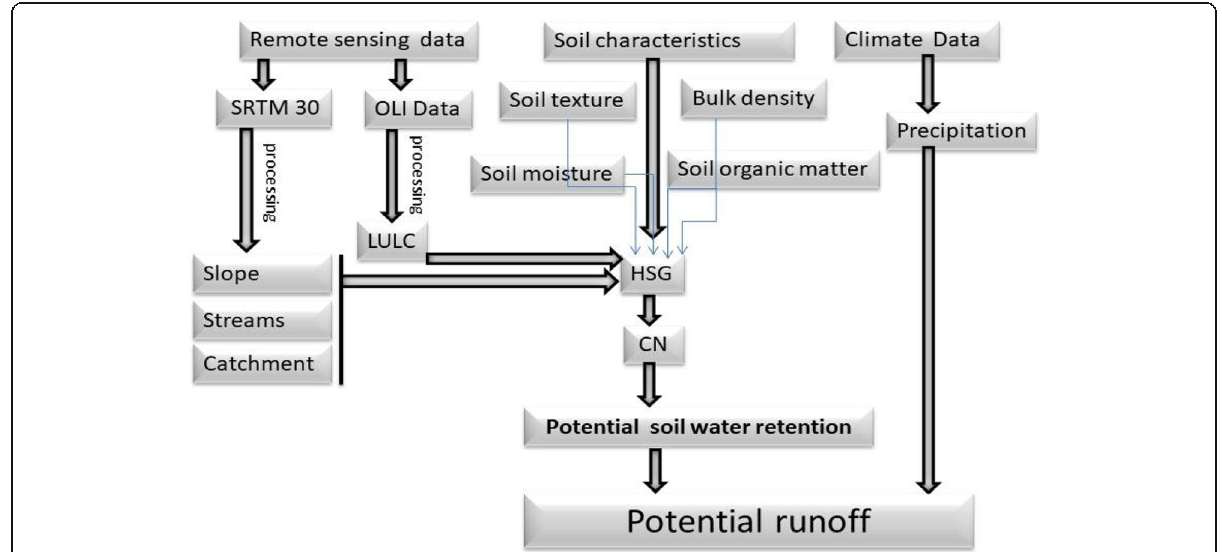
Fig. 2 Flow chart of the method that used to identify the direct surface runoff using the NRCS-CN model and the GIS